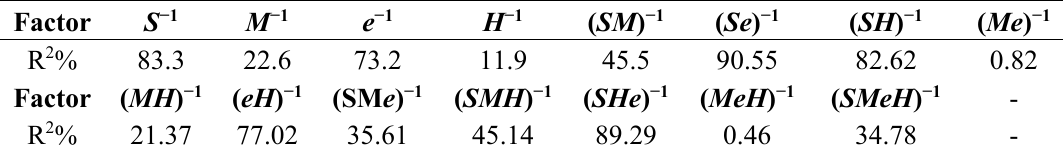
Table 4. Correlation analysis results of the correlation between the mechanical.